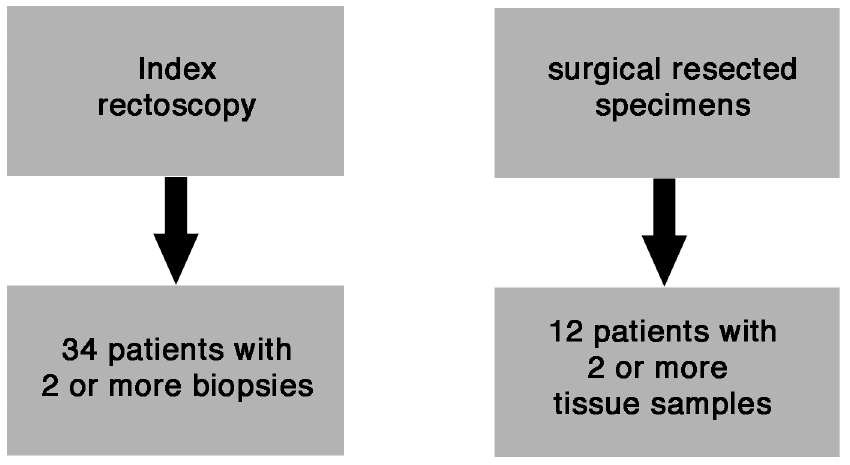
Fig 4. Figure showing tumor samples used for analysis for intratumoral heterogeneity within biopsies from index rectoscopy and surgically resected